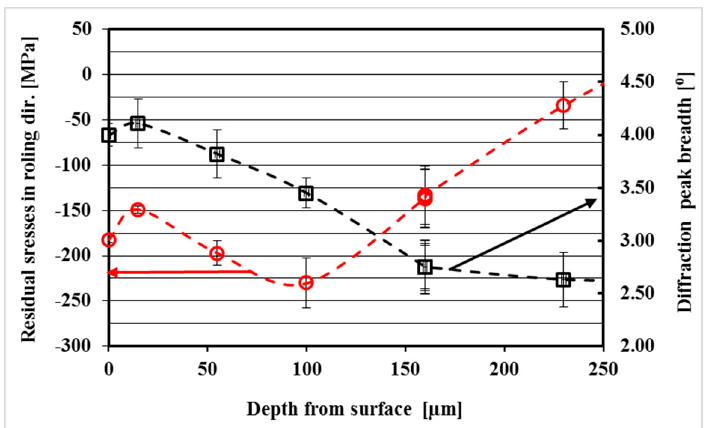
Figure 8. Residual stresses profile and X-ray diffraction peak breadth against the depth from surface for SP specimens. “ ○ ” corresponds to the residual stress in rolling direction (MPa) and “ □ ” to the diffraction peak breadth (°).